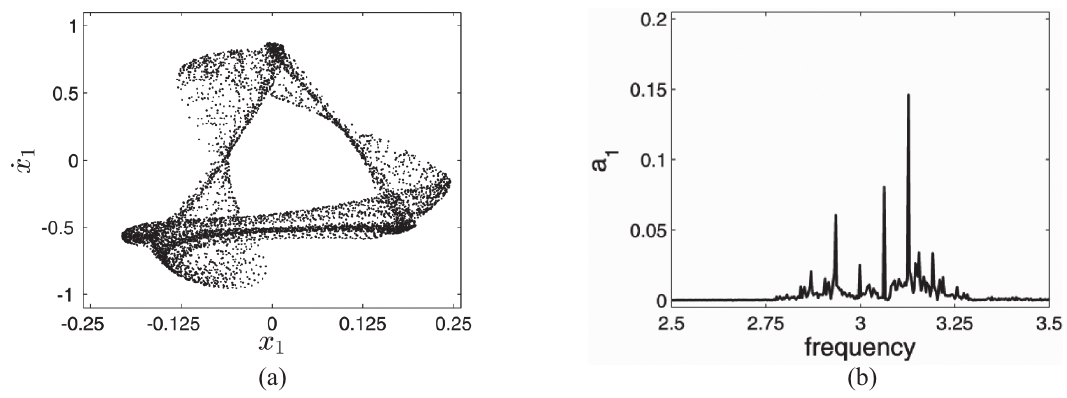
Fig. 15. Poincaré map (a) and fast Fourier transform (b) of the beam response; x 0 = 0.01, Ω = 3.06309, α 2 = 0.00306, α 1 = 0.015.